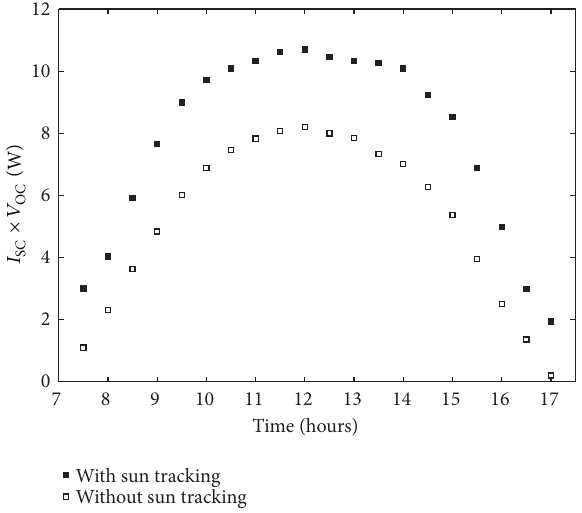
Figure 11: The power generation comparison of the fixed angle and tracking systems (experiment on October